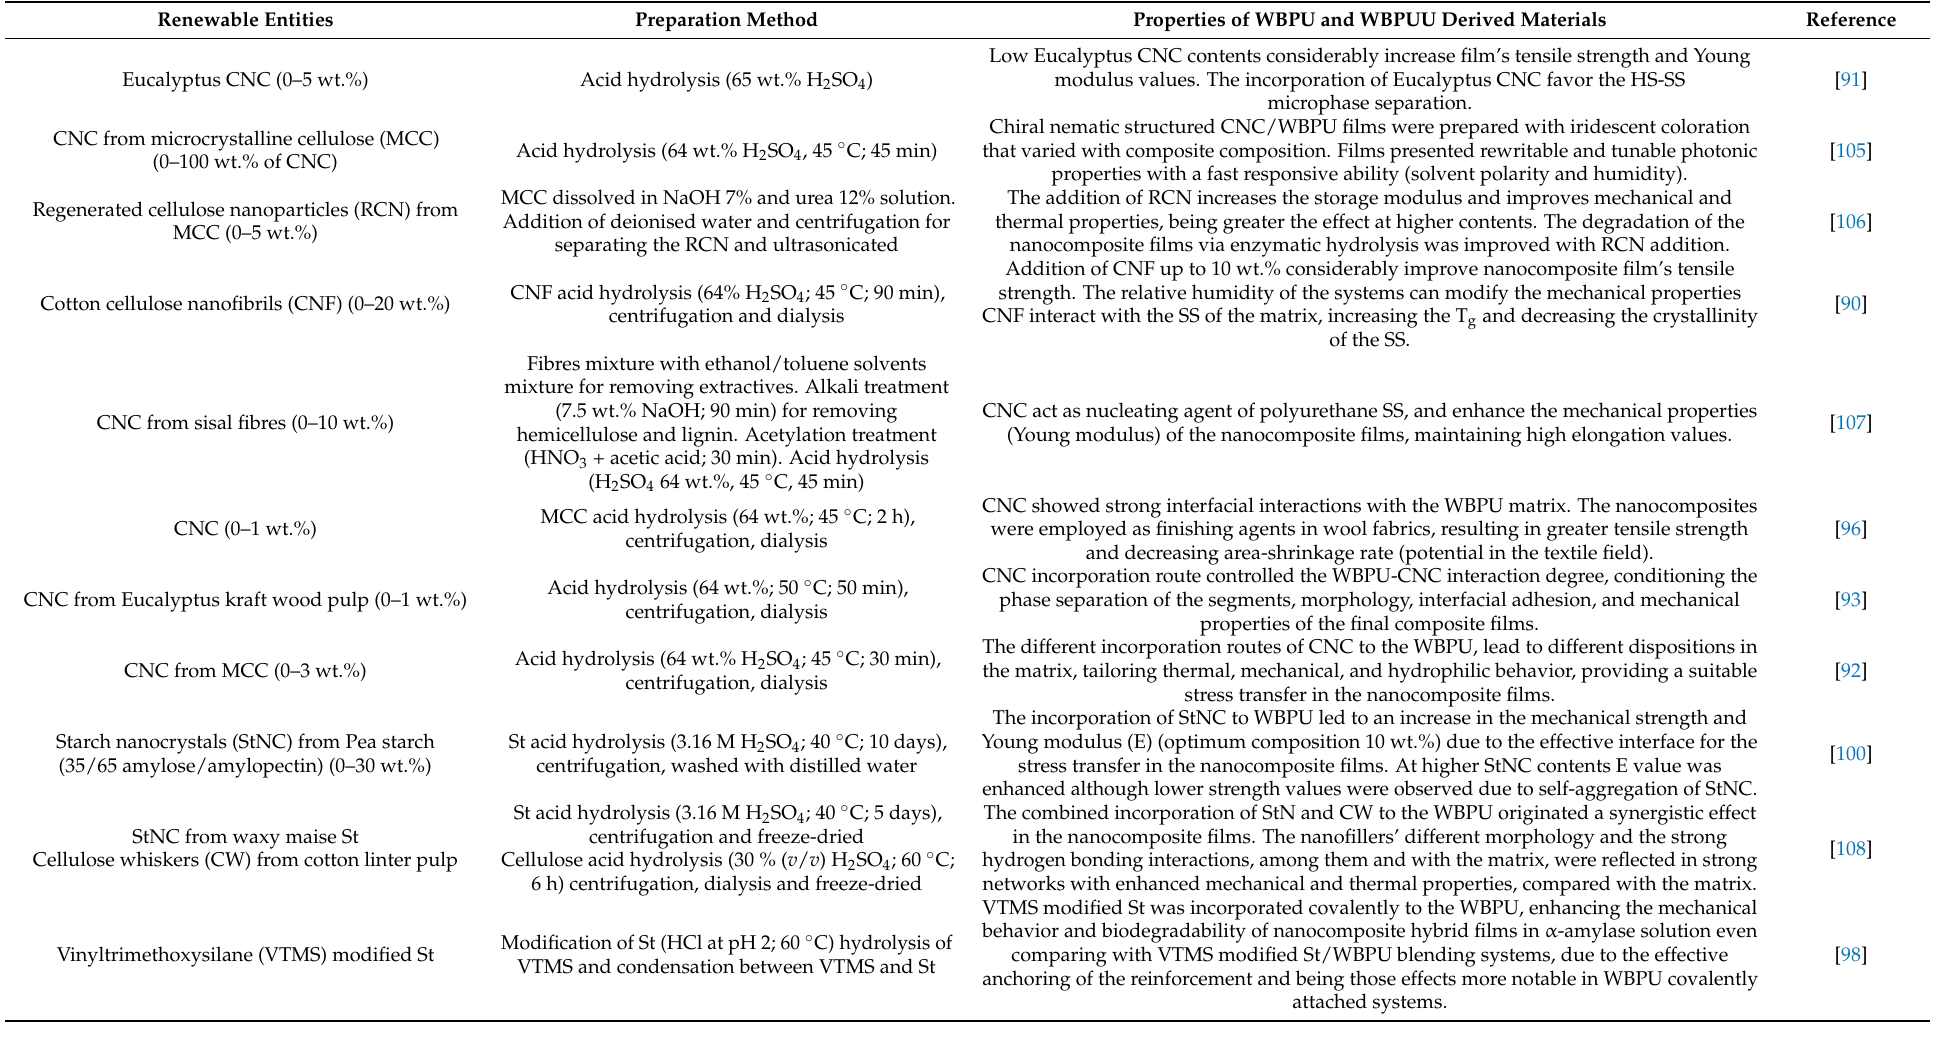
Table 3. WBPU and WBPUU reinforced with renewable entities, their preparation method, and effect on final properties of the derived